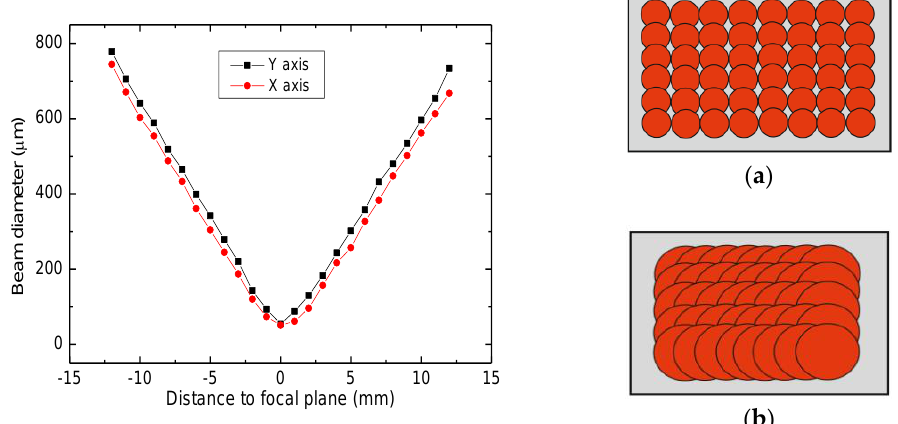
Figure 5. Beam diameter out of focus. At the focal plane, almost non-overlapping spots were ob- tained ( a ). Increasing defocusing, overlap increased due to significantly larger beam diameter ( b ). A set of experiments was performed with a 1064 nm wavelength. The sample was placed at the focal plane initially. Later, the sample was moved down below the focal plane by 3 mm. The irradiation dose in this distance was from 130 J/cm 2 (at the focal plane) to 17.75 J/cm 2 (3 mm below the focal plane). Soot was formed on the sample surface in this fabrication range (Figure 6a). Strong dependence of sheet resistance and applied irradia- tion dose were observed after fabrication in this defocus range. A thicker layer of soot formed when treated with a high irradiation dose and, accordingly, surface sheet re- sistance was lower. Sheet resistance was as low as 30 Ω/square when treated at the focal plane with 130 J/cm 2 irradiation dose, and 20 MΩ/square when treated at 3 mm below the focal plane with a 17.75 J/cm 2 irradiation dose. Figure 6. Microscope images of the sample surface: ( a ) treated at the focal plane. Soot appeared on the surface of the sample; ( b ) treated 4 mm below the focal plane, where clusters of gray-colored structures formed; ( c ) treated 7 mm below the focal plane. LIG structures, with smooth surface and low sheet resistance, were formed in this regime.